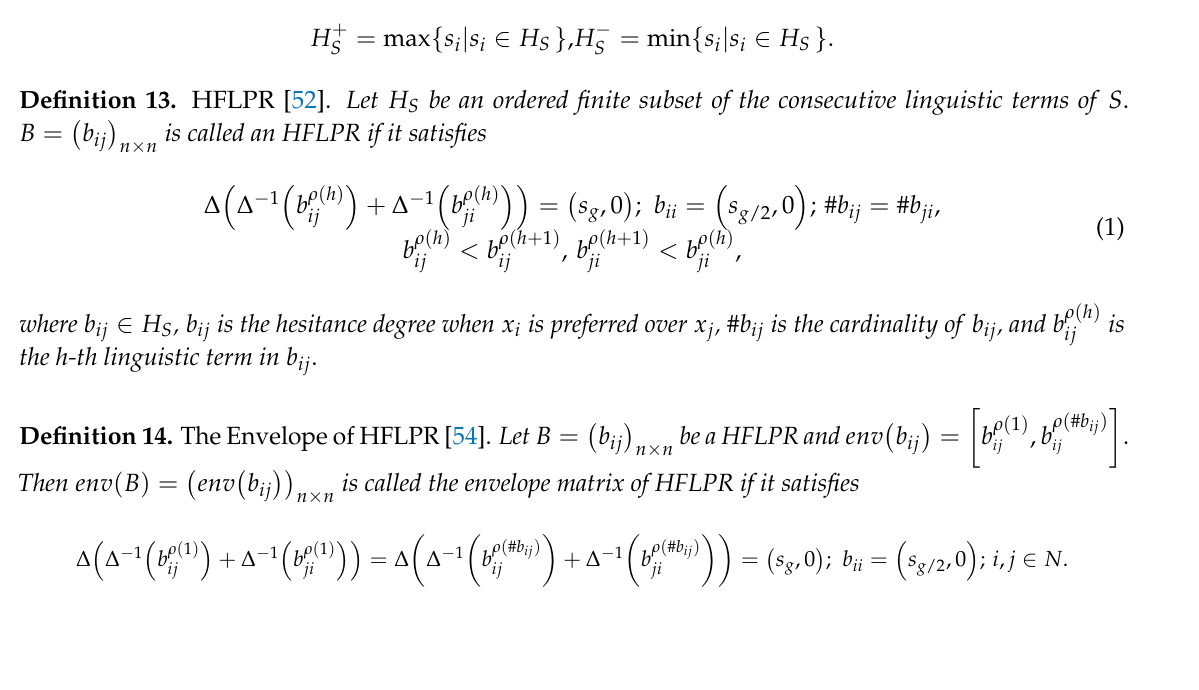
According to Definitions 8 and 9, the fuzzy number information can be transformed into its equivalent 2-tuple linguistic. Conversely to this, a 2-tuple linguistic can be transformed into its equivalent fuzzy number through the following